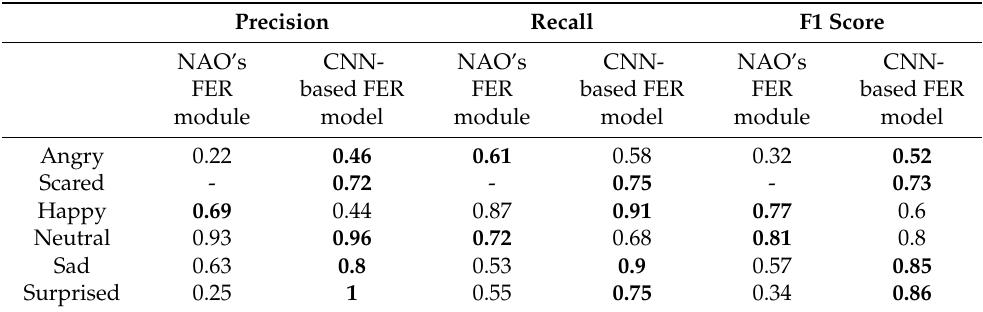
Table 1. Precision, recall, and F1 score achieved by NAO’s FER module on the experimental data for each output class compared to those of the CNN-based FER module. The best performances are highlighted in bold.